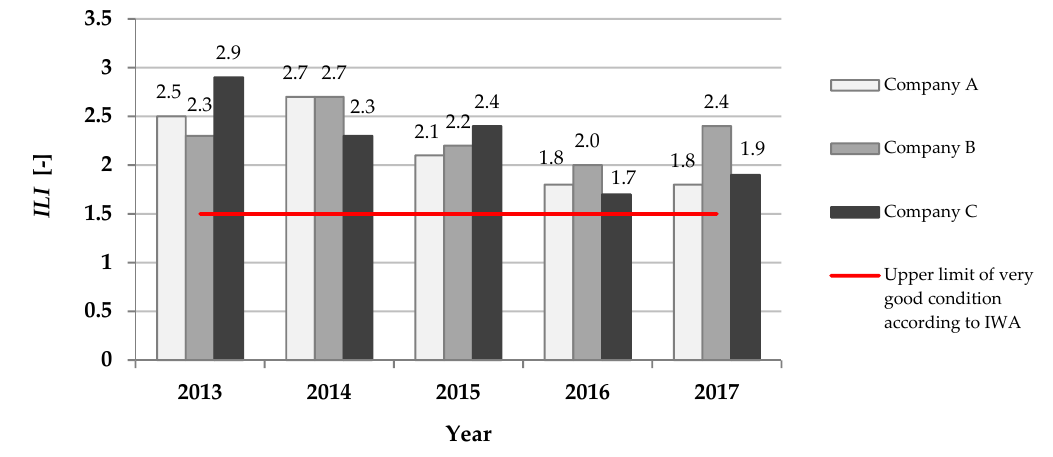
Figure 2. Infrastructure Leakage Index— ILI.